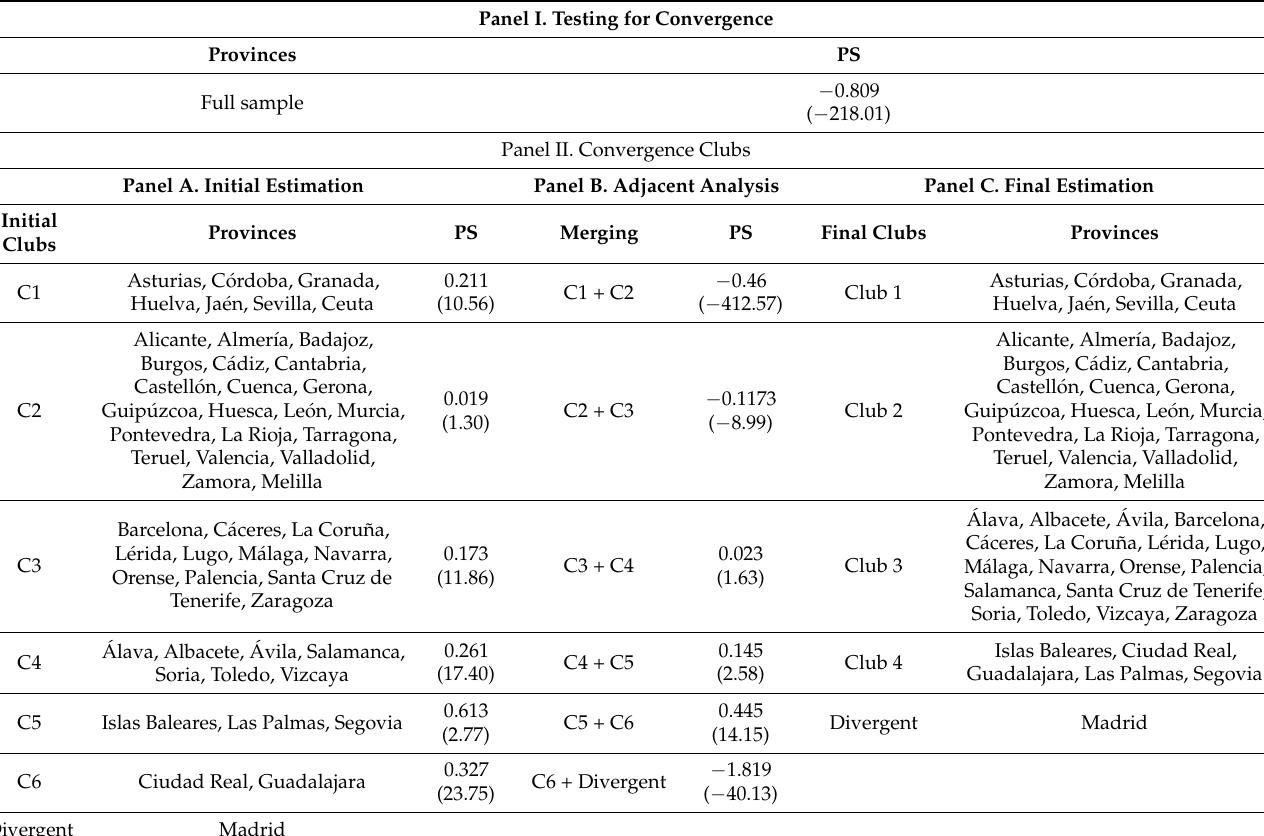
Table 2. Testing for convergence and convergence clubs. Panel I. Testing for